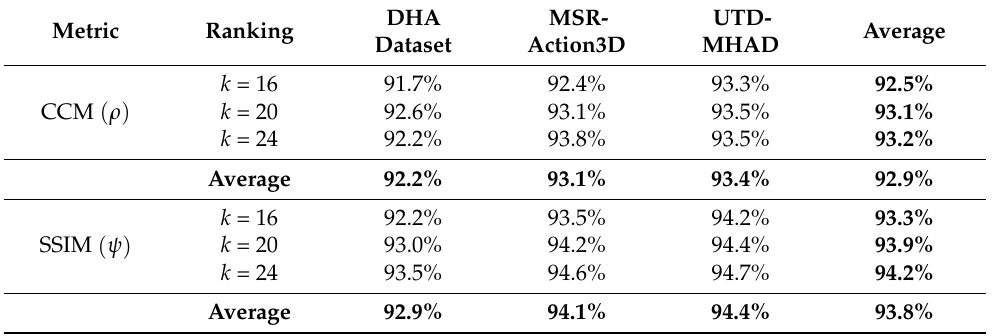
Table 1. Human action recognition results on the DHA, MSR-Action3D, and UTD-MHAD datasets.